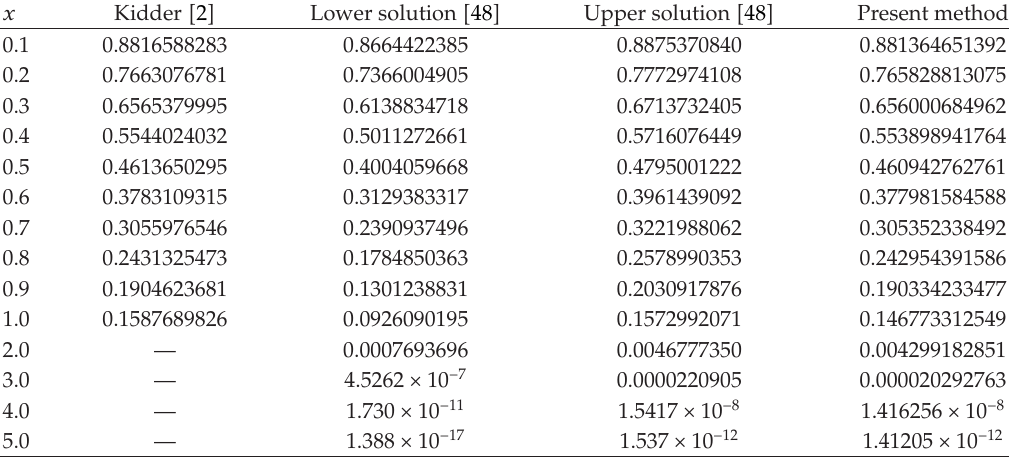
Table 4: Approximate, lower, and upper values of y (cid:4) x (cid:3) for Example